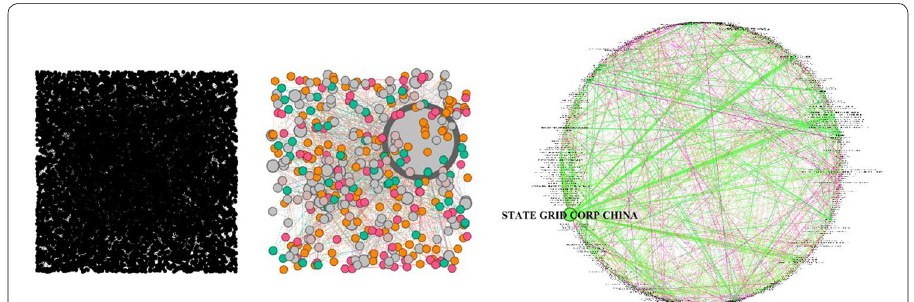
Fig. 1 From left to right: the first network is the initial visualization of the network of co-applicants with no filtering; the second one is the network after applying the steps 1 and 2; and the third network is after the applying the circular